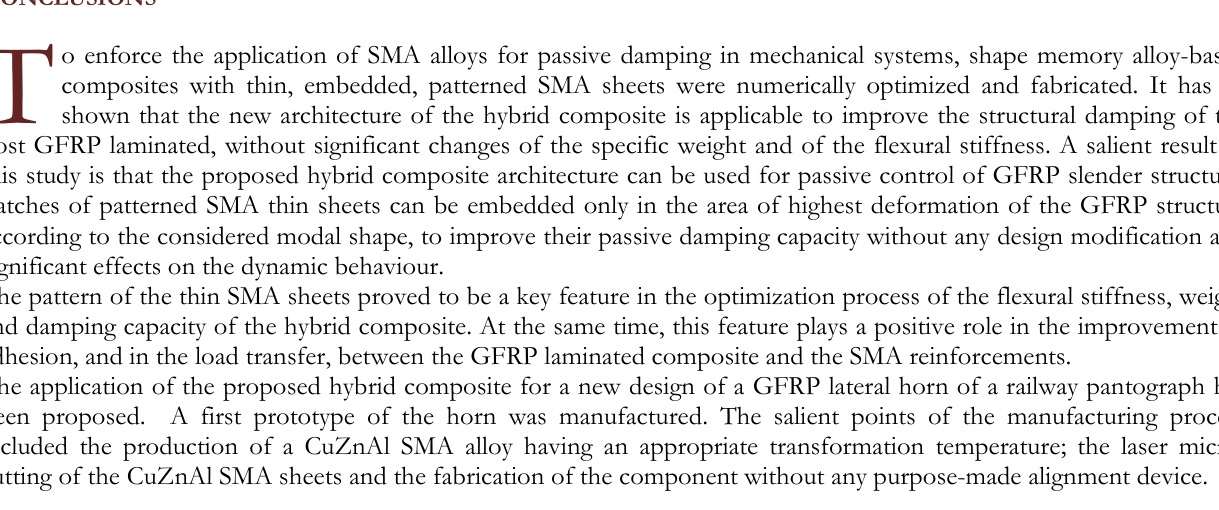
Table 7: Tan  e non-dimensional damping (h) for the three horns when the displacement is equal to 1 mm. C